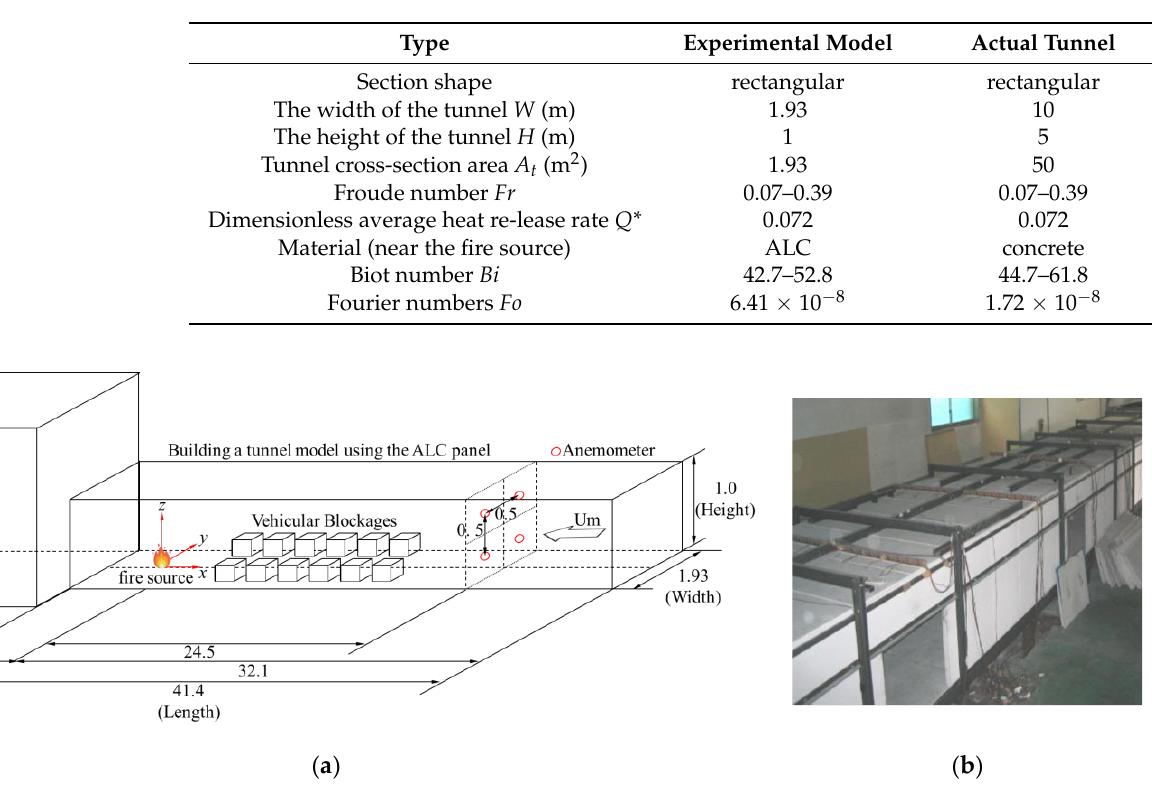
Figure 2. Model tunnel structure and compositional diagram: ( a ) Dimensions and configuration of the tunnel model (unit: meters); ( b ) Photo of tunnel model. Table 2. List of model tunnels and actual tunnels.